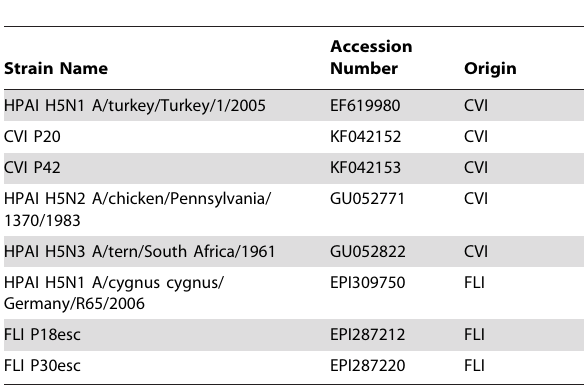
Table 1. List of strains used for antigenic cartography